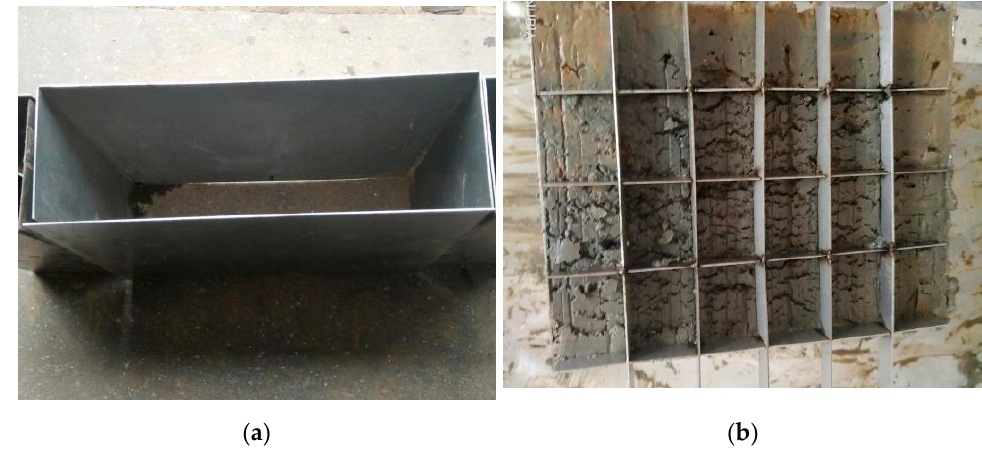
Figure 2. Soil sampling tool ( a , b ).